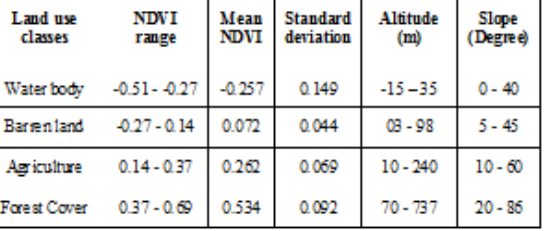
Table 2. NDVI, altitude and slope of some LULC